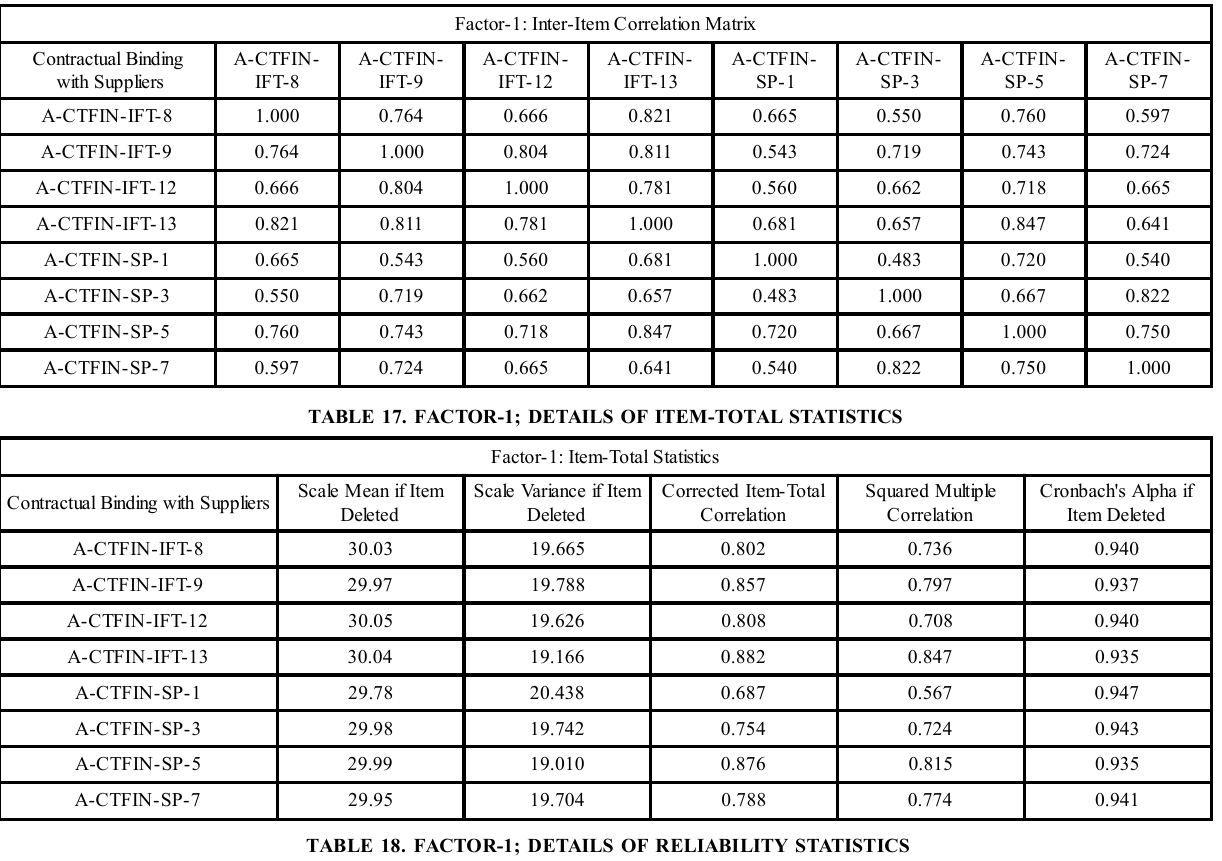
TABLE 16. FACTOR-1; DETAILS OF INTER-ITEM CORRELATION MATRIX